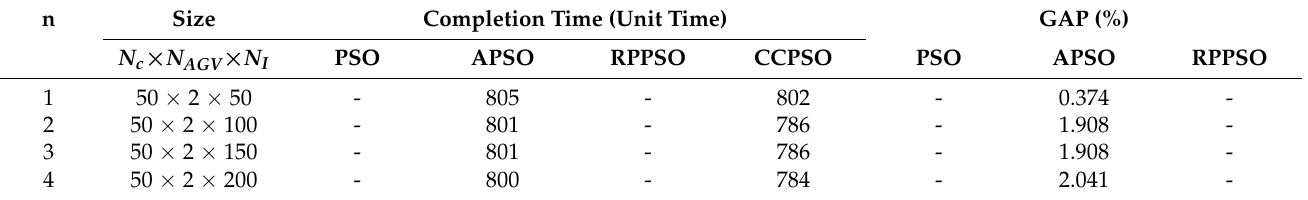
Figure A4. Numerical experiment: optimal solution update. Table A3. Comparison experiment of PSO, APSO, RPPSO and